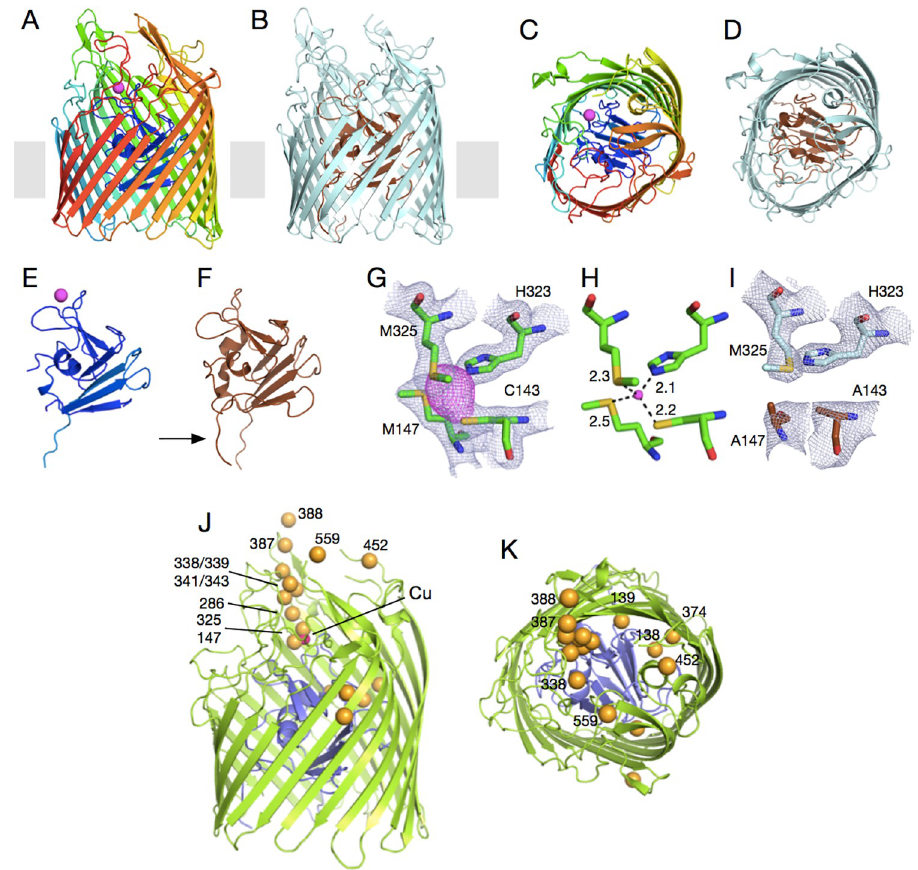
Fig 1. OprC is a TBDT that binds ionic copper via an unprecedented CxxxM-HxM binding site. Cartoon representation of (A, C) Cu-loaded OprC and (B, D) Cu-free OprC (OprC AA ). (A, B) are viewed from the OM plane, whereas the views for (C, D) are from the outside of the cell. The N-terminal plug domain is shown separately for both forms (E, F). For Cu-OprC, structures are shown in rainbow from N-terminus (blue) to C-terminus (red); copper is represented as a magenta sphere. Apo-OprC is coloured light cyan, with the plug rendered brown. The arrow in (F) highlights the visibility of the Ton box in apo-OprC. (G) Stick models of copper-coordinating residues Cys143, Met147, Met325, and His323. Electron density in grey mesh (2Fo-Fc map contoured at 2.0 σ , carve = 2.0) is shown for the binding site residues C/M-H/M and the copper atom (anomalous difference map shown in magenta, contoured at 3.0 σ , carve = 2.25). (H) Distances between coordinating residues and metal show that copper is coordinated via 1 thiolate (from Cys), 2 thioethers (from Met), and 1 imidazole nitrogen from His. (I) Mutation of binding site residues Cys143 and Met147 to alanines in OprC AA abolishes copper binding (2Fo-Fc map contoured at 2.0 σ , carve = 2.0). (J, K) OM plane (J) and extracellular views (K) showing the thioether atoms of all methionine residues in Cu-OprC as yellow spheres. The copper atom, only visible in (J), is shown as a magenta sphere. OM AU : AbbreviationlistshavebeencompiledforthoseusedinFigs 1 (cid:0) 4 : Pleaseverifythatallentriesarecorrect : , outer membrane; TBDT, TonB-dependent transporter. (Fig 1A, 1C, and 1E). The copper binding site comprises residues Cys143 and Met147 in the plug domain and His323 and Met325 in the barrel wall. The CxxxM-HxM configuration, which coordinates the copper in a tetrahedral manner (Fig 1G and 1H), is highly unusual and has, to our knowledge, not been observed before in copper homeostasis proteins. A similar site is present for one of the copper ions of the valence-delocalised Cu dimer in cytochrome c oxi- A dase, where the copper ion is coordinated by 2Cys+1Met+1His [30,31]. Other similar sites are class I Type I copper proteins like pseudoazurin and plastocyanin, where copper is coordinated by 2His+1Cys+1Met [32]. Interestingly, and unlike class I Type I copper proteins, concen- trated solutions and OprC crystals are colourless in the presence of Cu(II). Another notable